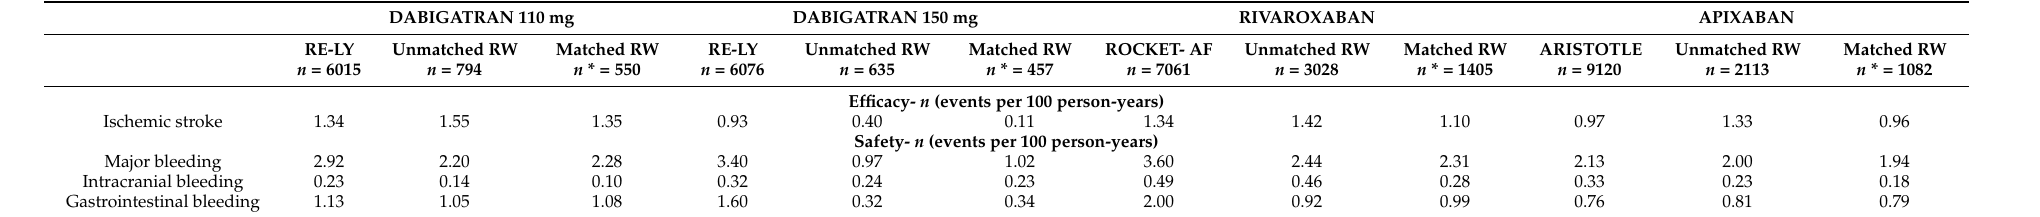
Table 2. Efficacy and safety outcome rates in RCT population vs. RW unmatched population vs. RW 1:1 matched